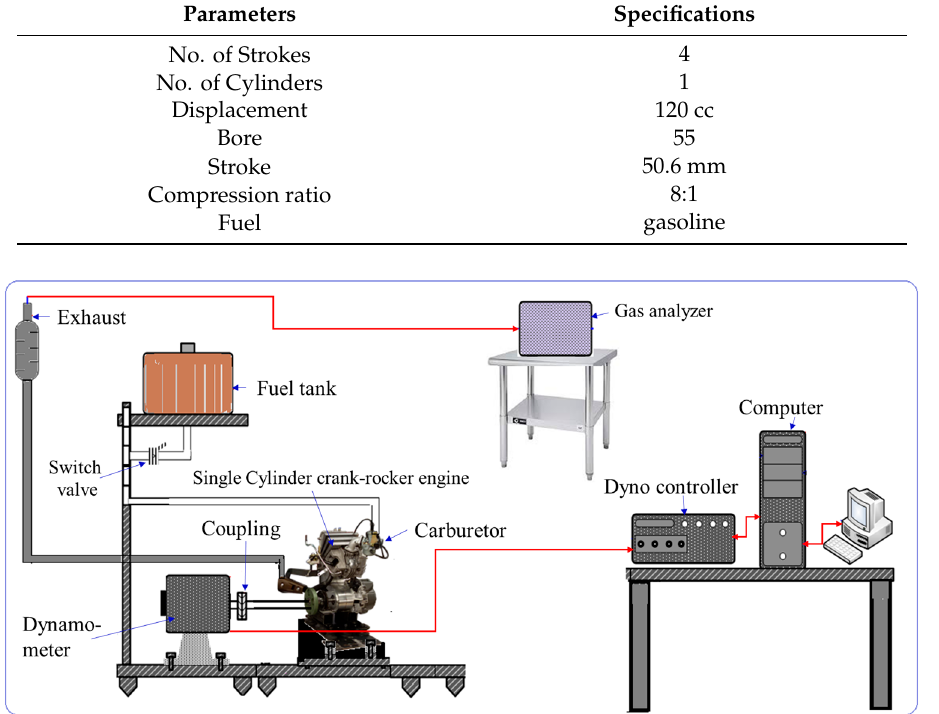
Figure 5. Crank-rocker gasoline engine experimental set-up.